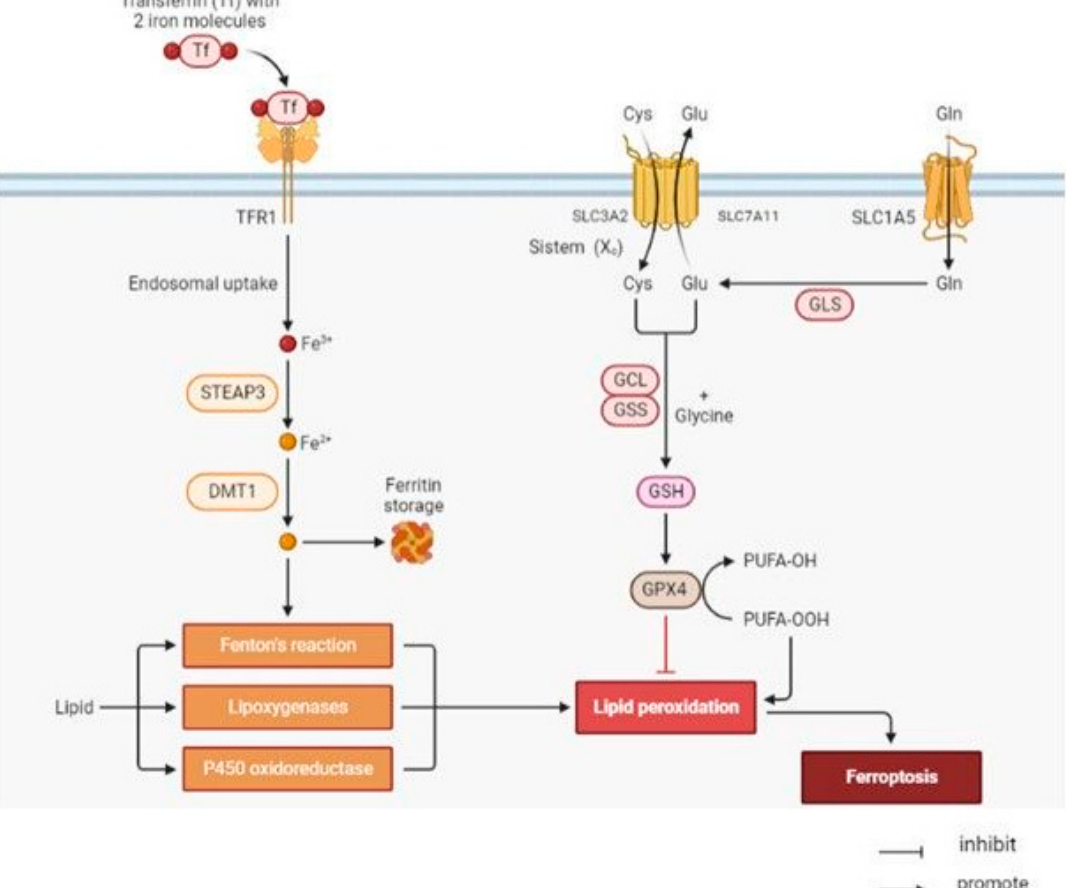
Figure 1. Schematic view of the ferroptosis pathways. Ferroptosis pursues upon build-up of lipid reactive oxygen species (ROS) leading to peroxidation of polyunsaturated fatty acids (PUFAs). Lipid peroxidation can be triggered by cytosolic redox active iron (Fe 2+ ) shuttled into cells bound to transferrin via transferrin receptor (TFRC) endocytosis and endosomal release mediated by divalent metal transporter 1 (DMT1). In the presence of H 2 O 2 , Fe 2+ catalyses hydroxyl radical (HO · ) generation in Fenton reaction, which sets of a radical lipid peroxidation chain reaction. Lipoxygenase (LOX) can equally catalyse lipid peroxidation using Fe 2+ . Glutathione peroxidase 4 (GPX4), in turn, hydrolyses lipid peroxides converting them into their respective non-toxic lipid alcohols (-OH). GPX4 requires glutathione (GSH) as a cofactor which upon its oxidation (GSSG) by GPX4 is reduced to GSH by glutathione reductase (GR). GSH synthesis de- pends on glutamate cysteine ligase (GCL) and glutathione synthetase (GSS) as well as on intracellular cystine shuttled into the cell in exchange for glutamate mediated by system xc-(SLC3A2 and